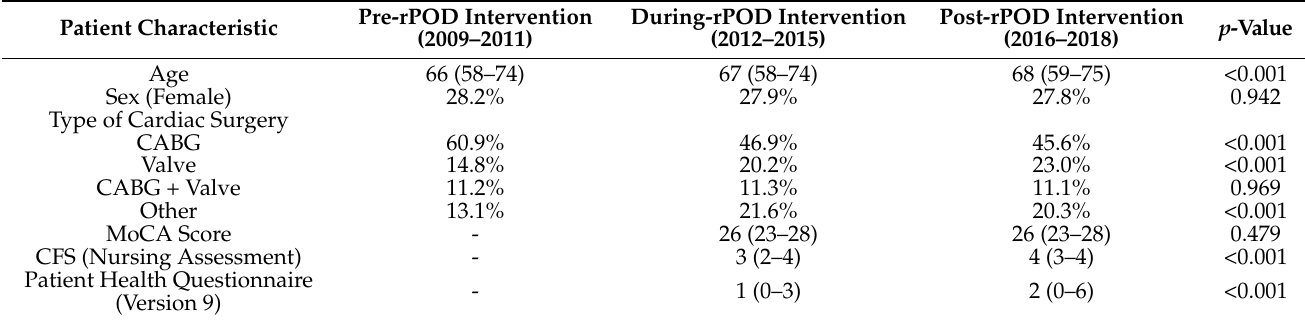
Table 6. Patient Characteristics During Delirium Quality Improvement Period.